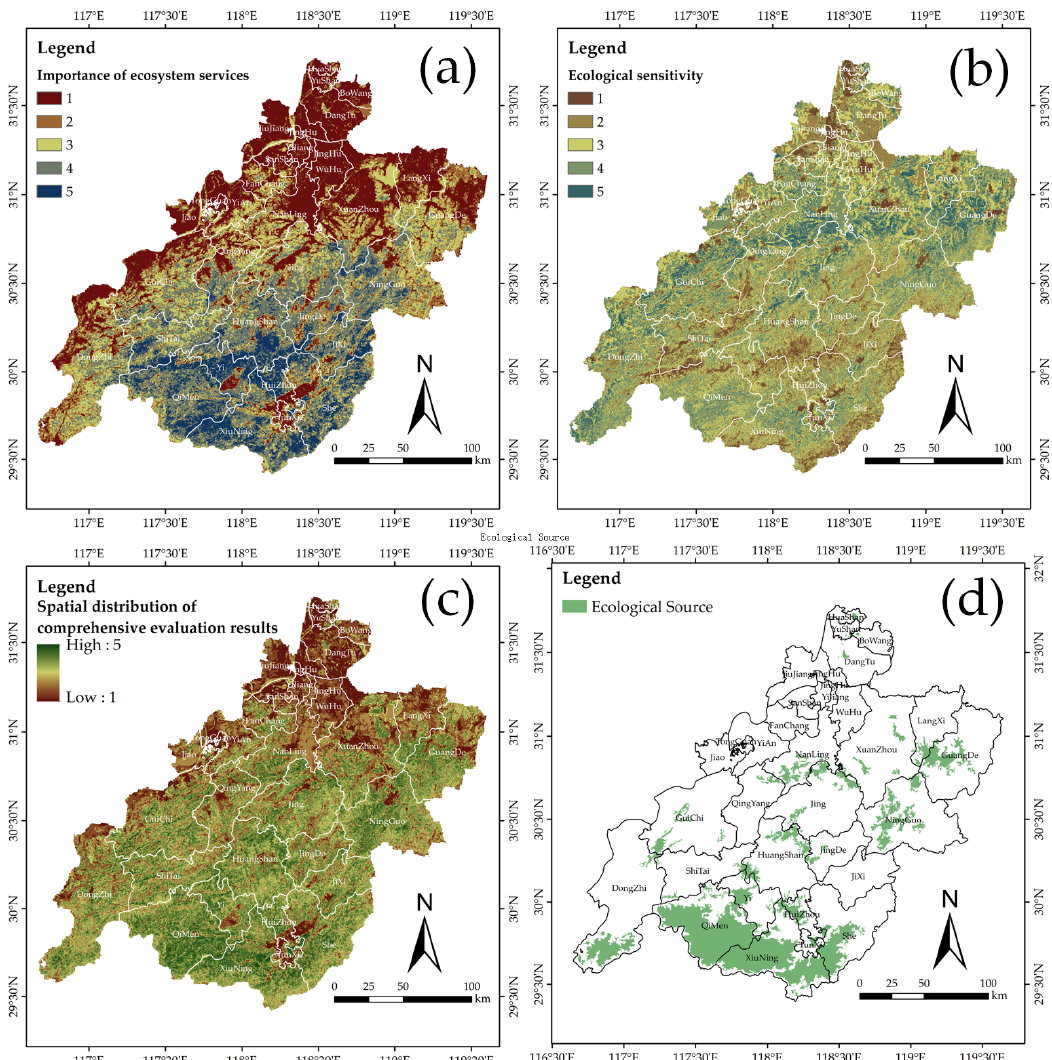
Figure 7. Construction of ecological source sites in southern Anhui; ( a ) is the importance of ecosystem services; ( b ) is the ecological sensitivity; ( c ) is the spatial distribution of comprehensive evaluation results; ( d ) is the ecological source. (Note: 1 to 5 as extreme, slightly poor, medium, good, and excellent, respectively).